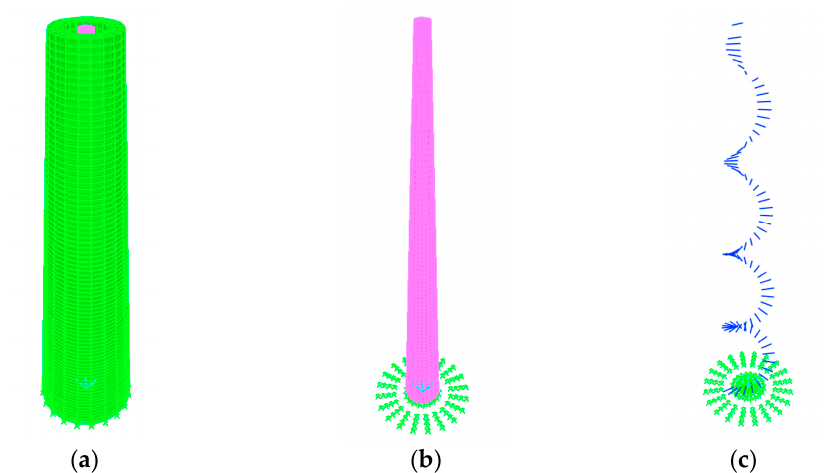
Figure 17. Major components of finite element model: ( a ) core tower with outer wall; ( b ) core tower only; ( c ) staircase.